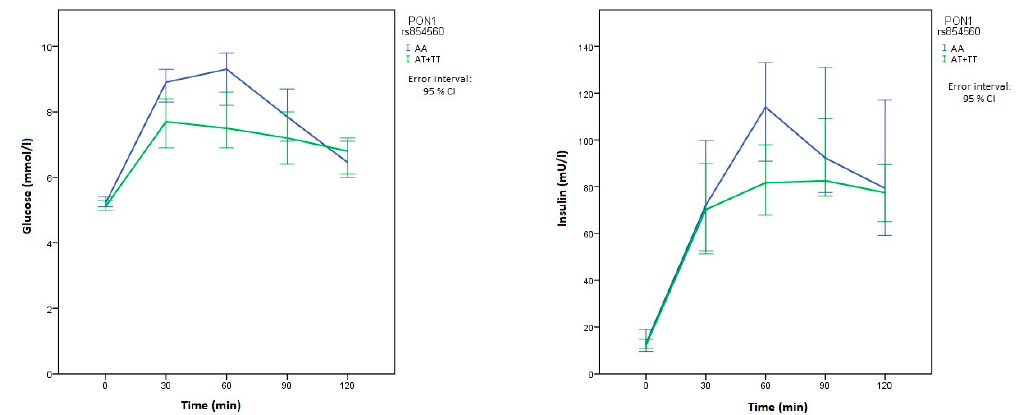
Figure 1. Time course of glucose and insulin levels for PON1 rs854560. The blue line represents the reference genotype, while the green line represents patients with at least one polymorphic allele.